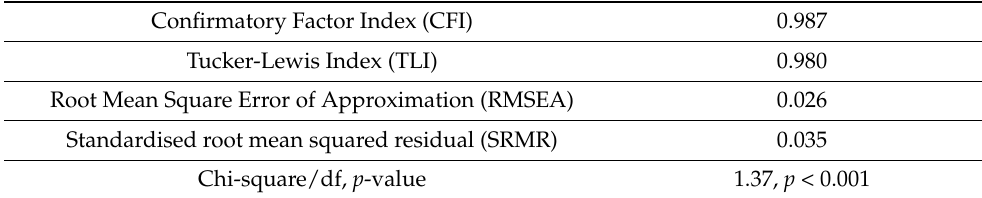
Table 2. Fit indices of the Structural Equation Modeling